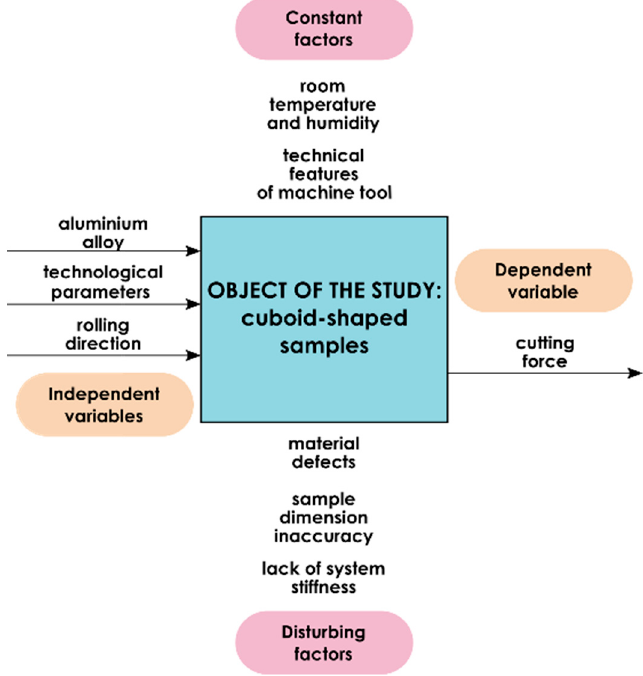
Figure 1. Research plan.